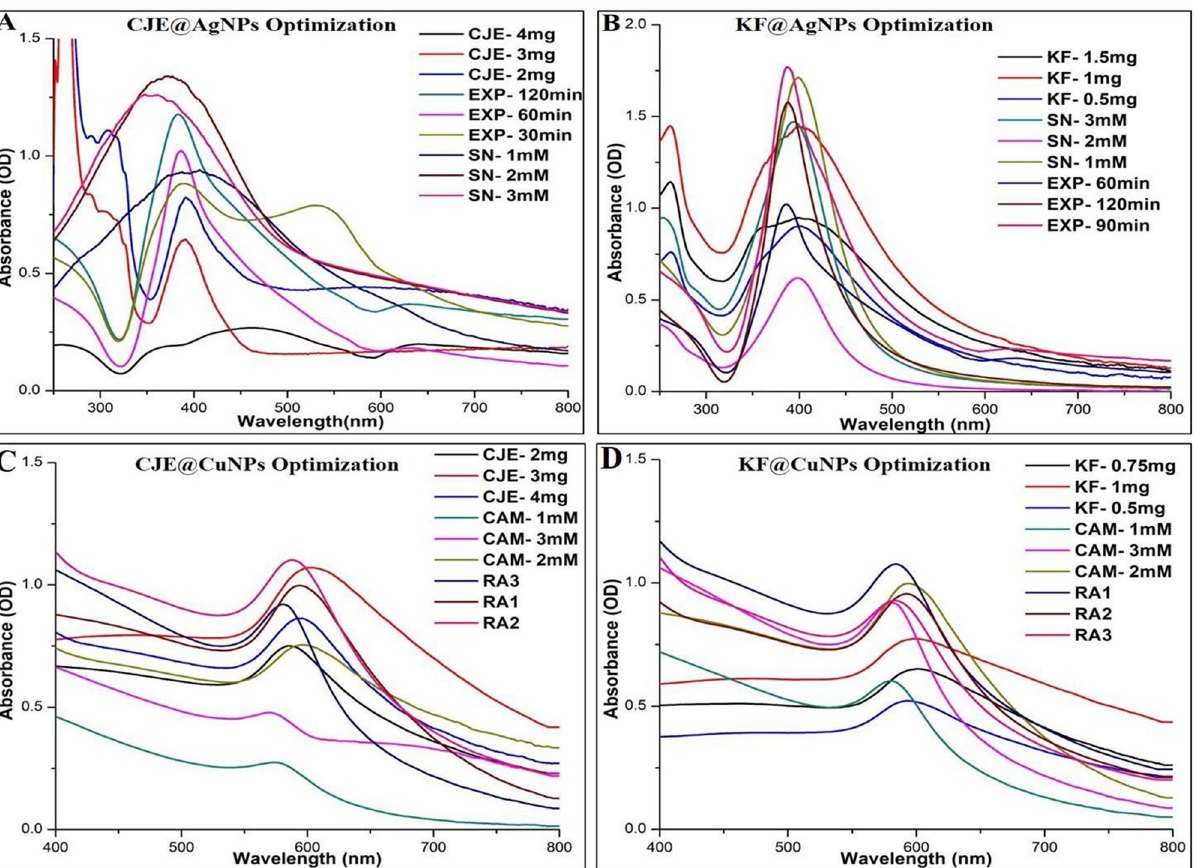
Figure 1. Optimization studies for the synthesis of Crotalaria juncea extract and Kaempferitrin capped AgNPs/ CuNPs ( A ). CJE (2, 3 and 4 mg/mL) Vs SN (1 mM) and EXP (1 h); SN (1, 2 and 3 mM) Vs CJE (Optimized concentration) and EXP (1 h); EXP (1, 2 and 3 h) Vs CJE (Optimized concentration) and SN (optimized molarity). (B). Kaempferitrin (0.5, 1 and 1.5 (mg/mL) Vs SN (1 mM) & EXP (60 min); SN (1, 2 and 3 mM) Vs Kaempferitrin (Optimized concentration) & EXP (1 h)’ iii) EXP (60, 90 and 120 min) Vs Kaempferitrin (Optimized concentration) & SN (optimized molarity). ( C ). CJE (2, 3 and 4 mg/mL) Vs CAM (1 mM) and RA1 (µL/mL); CAM (1, 2 and 3 mM) Vs CJE (Optimized concentration) and RA1 (µL/mL); RA (1, 2 and 3 µL/ mL) Vs CJE (Optimized concentration) and CJE (optimized molarity). ( D ). Kaempferitrin (0.5, 0.75 and 1 mg/ mL) Vs CAM (1 mM) and RA1 (µL/mL);, CAM (1, 2 and 3 mM) Vs Kaempferitrin (Optimized concentration) and RA1 (µL/mL); RA (1, 2 and 3 µL/mL) Vs Kaempferitrin (Optimized concentration) and CAM (optimized